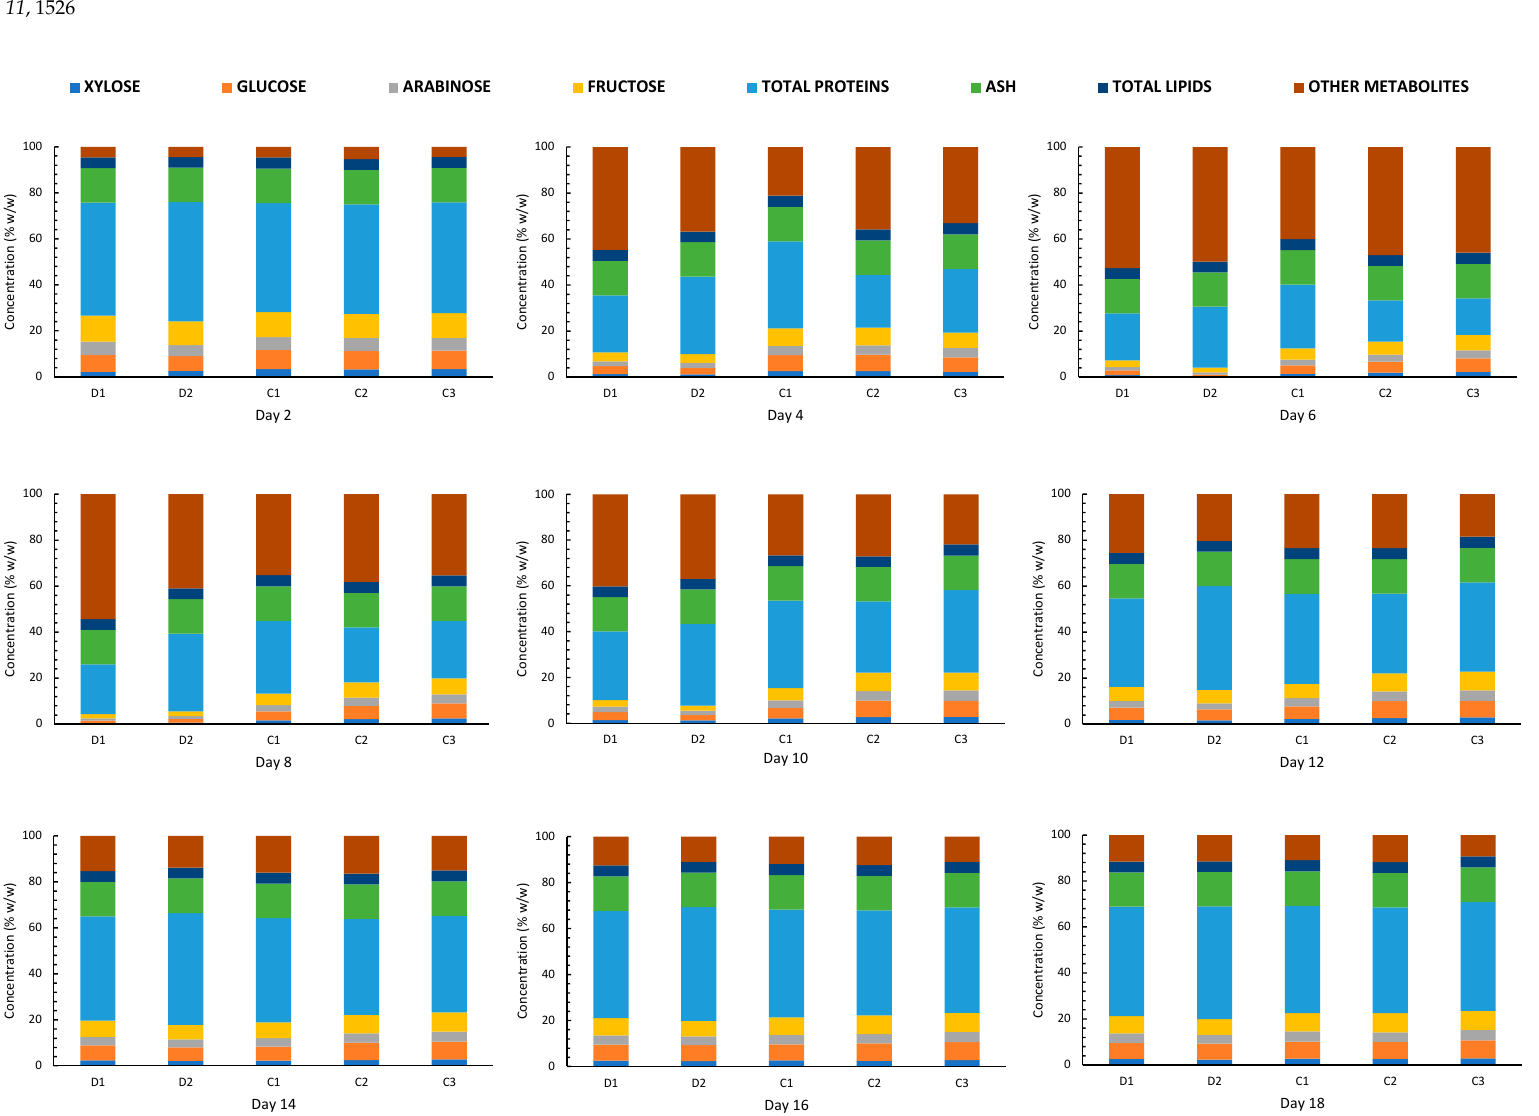
Figure 6. Changes in the composition of C. vulgaris over the 18-day period of treatments with diluted (D1, D2) and concentrated (C1, C2, C3) biomass.